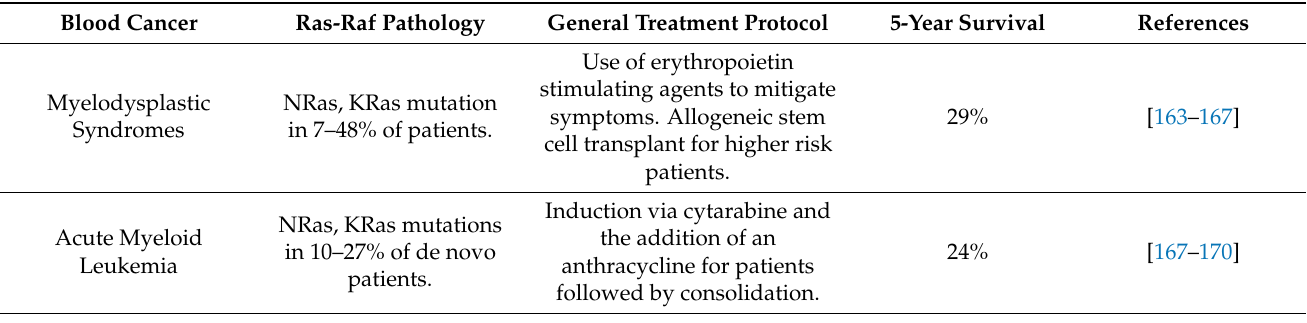
Table 1. Various blood cancers with Ras-Raf